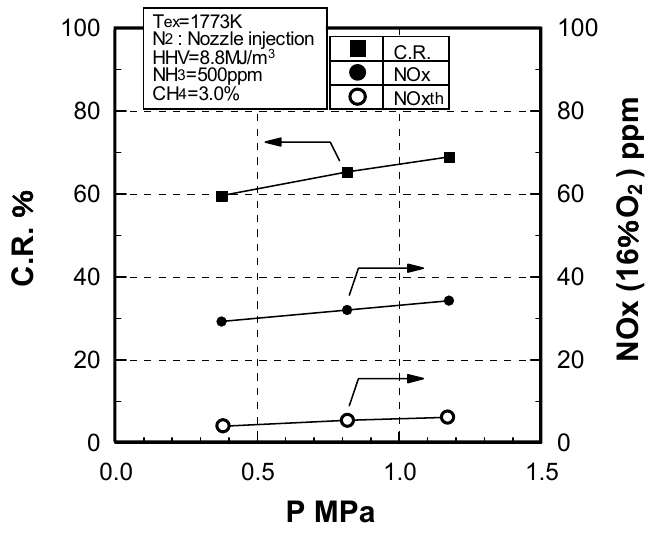
Figure 83. Effect of combustion pressure on NOx emission